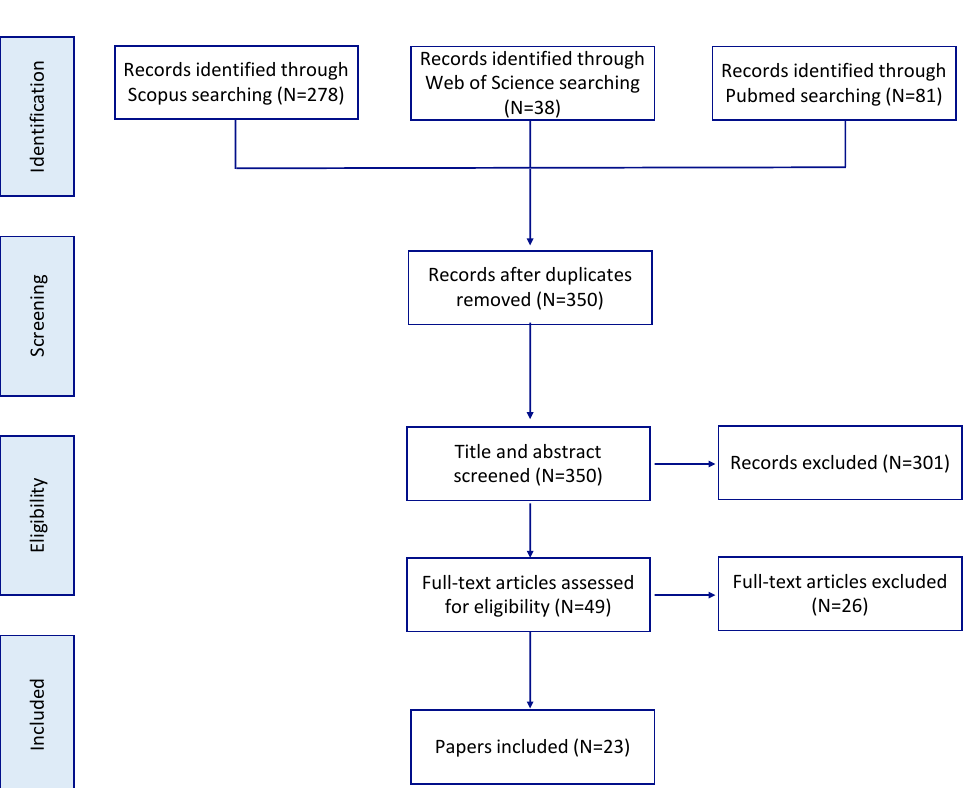
Figure A1. Literature search scheme based on PRISMA flowchart.